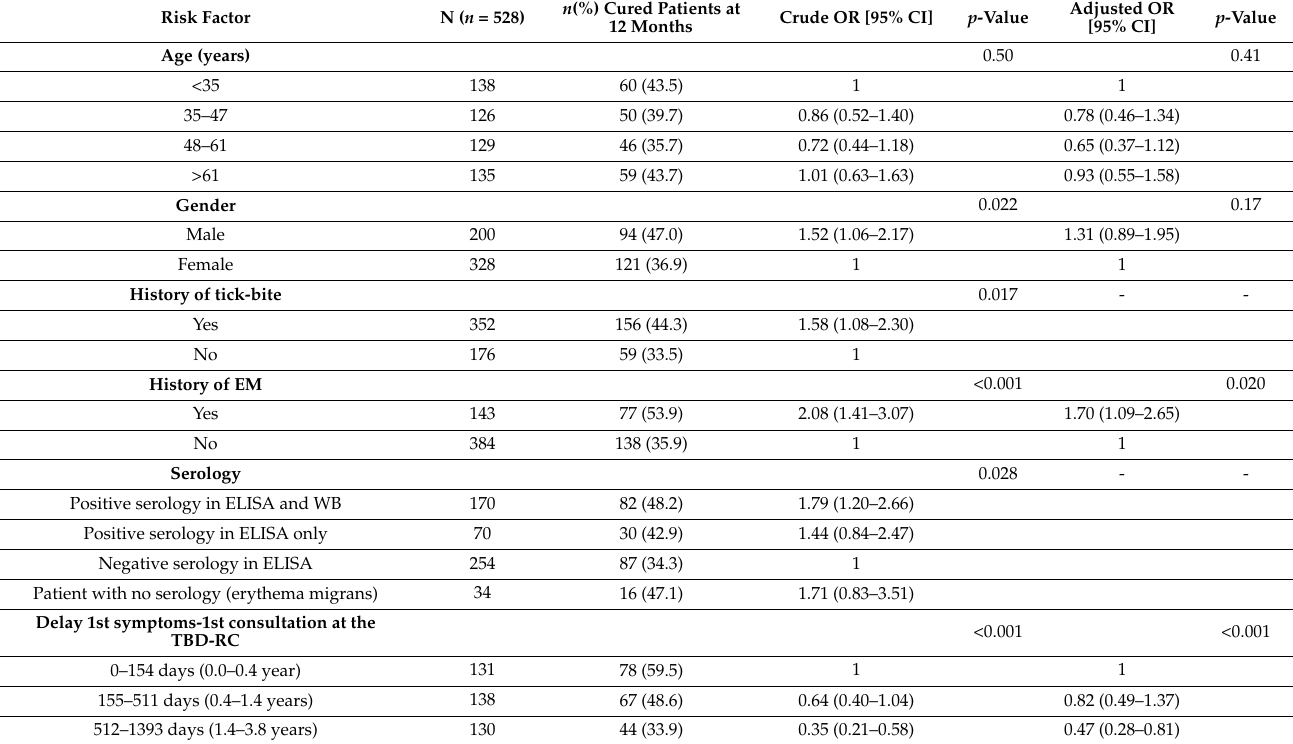
Table 6. Univariate and multivariate analyses of the associated factors with recovery versus par- tial improvement or stagnation or deterioration at 12 months after care at the TBD-RC-Paris and Northern